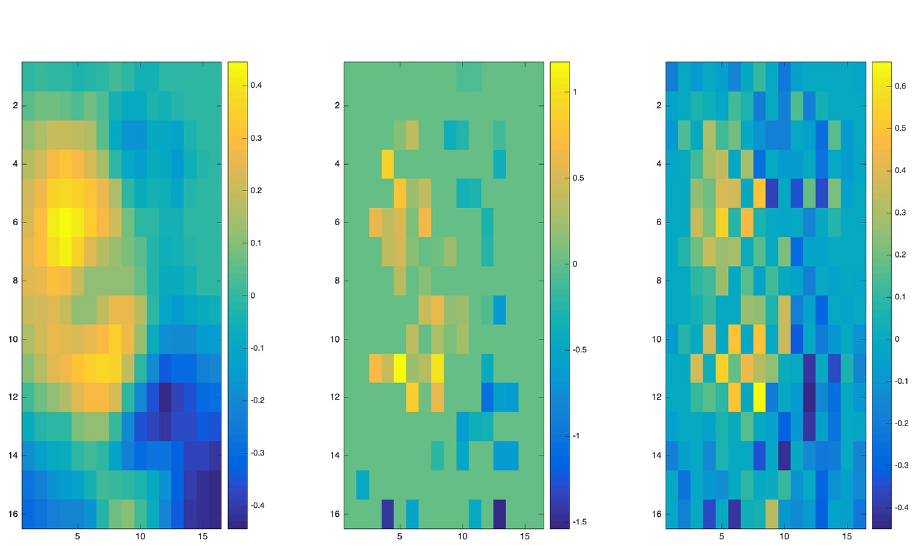
Fig 6. Real data analysis. The parameter image estimations. Left: the estimation of our proposed LG-sob; Middle: the estimation of LG- L 1 ; Right: the estimation of LG-fused.